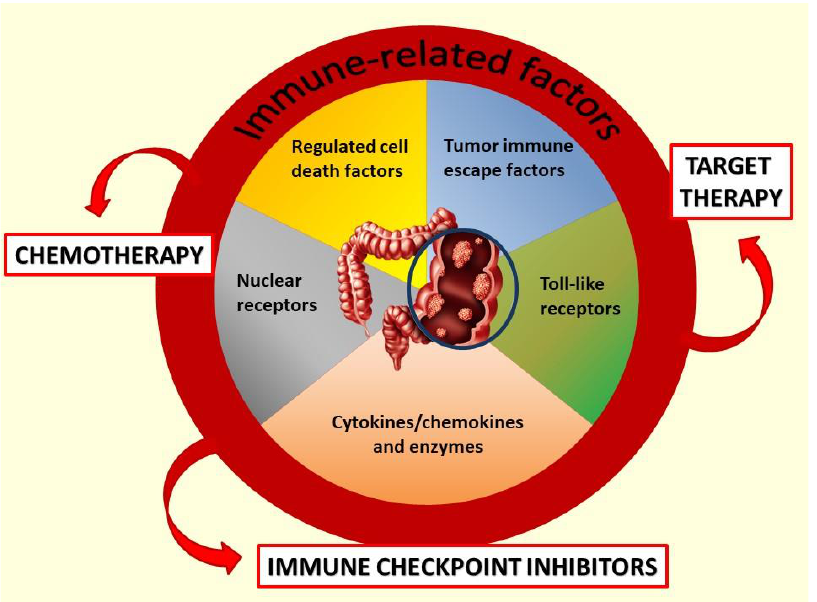
Figure 1. The interplay between immune-related factors and pharmacological strategies to fight mCRC.